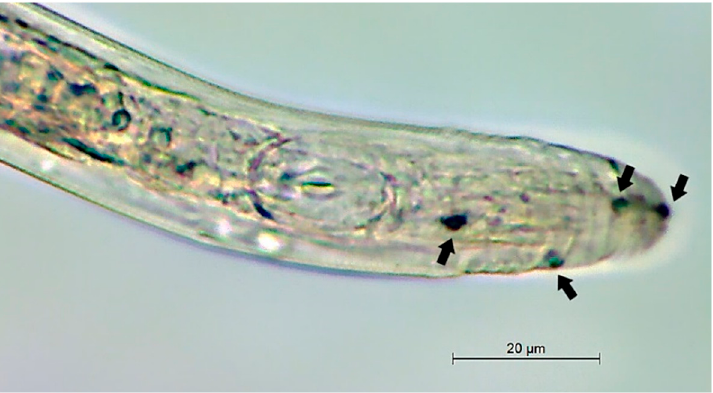
Figure 2. Cephalic region of Bursaphelenchus xylophilus , with spores of Esteya vermicola attached to the cuticle (arrows).